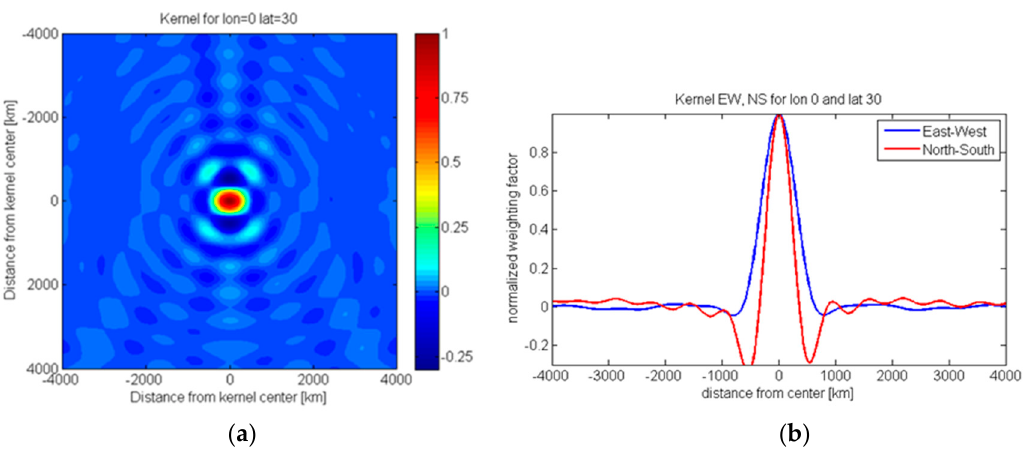
Figure 1. ( a ) Normalized 2D representation of the filter Kernel W α in the spatial domain, exemplarily shown for a geographical longitude of λ = 0 degrees, and latitude ϕ = 30 degrees north (center of figure). ( b ) Transection through the normalized smoothing kernel. In blue the east-west section and in red the north-south section through the center of the kernel are shown.